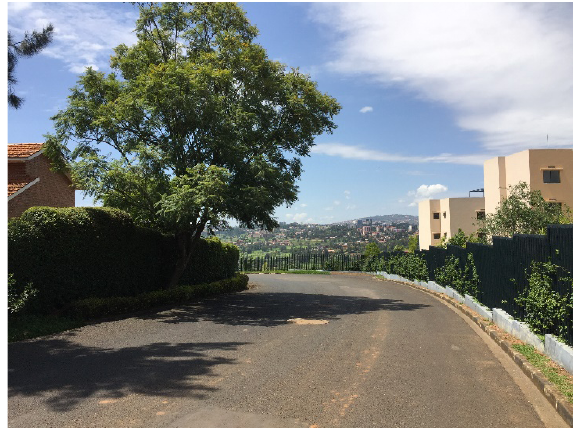
Figure 46. Umudugudu Kigali Vision: Road between the two settlements. Photograph by Manlio Michieletto.